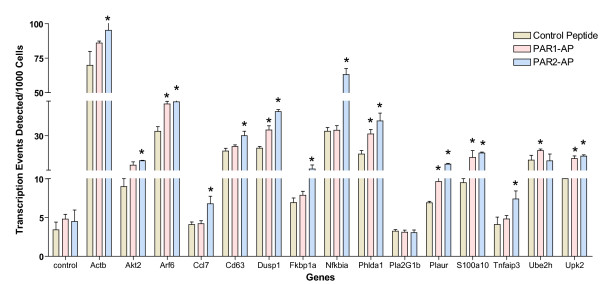
Target validation by Q-PCR of Chromatin Immunoprecipitation (CHIP)-Based Assays. For target validation, female C57BL/6J mice (n = 20 per group) were instilled with 200 μl of one of the following substances: control inactive peptide (LRGILS [94]) or PAR-activating peptides (PAR1-AP = SFFLRN [94]; PAR2-AP = SLIGRL [94]). Twenty-four hours after instillation, bladders were removed and frozen. Bladders were exposed briefly to formaldehyde for cross-linking of the proteins and DNA together, followed by sonication to fragment the DNA. An antibody against RNA polymerase II (Abcam) was then used to precipitate the DNA transcriptome that was isolated and then purified using phenol extraction and EtOH precipitation. The final CHIP DNAs were then used as templates for Q-PCR reactions using primer pairs specific for each gene of interest, additional material 2 (Table 2). Q-PCRs were run in triplicate and the averaged Ct values were transferred into copy numbers of DNA using a standard curve of genomic DNA with known copy numbers. The resulting transcription values for each gene were also normalized for primer pair amplification efficiency using the Q-PCR values obtained with Input DNA (un-precipitated genomic DNA). Results are presented as "transcription events detected per 1000 cells" for each gene tested. Error bars correspond to standard deviations from the triplicate Q-PCR reactions. Control represents an un-transcribed region of the genome. Asterisks indicate a statistical significant difference (p < 0.05).